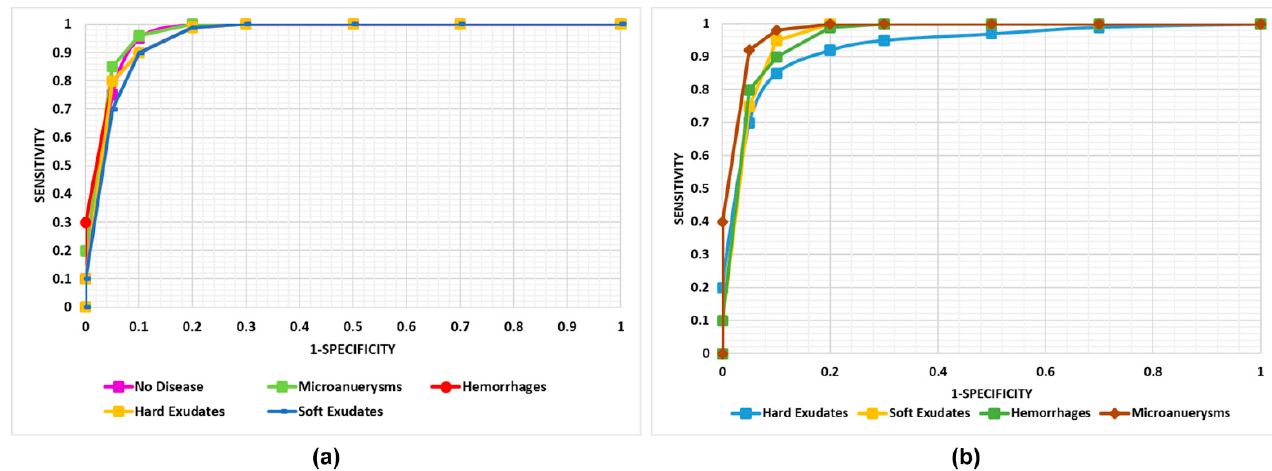
Figure 9. Cross dataset performance of our technique. ( a ) Test over the EYEPACS dataset. ( b ) Test over the Diaretdb1 dataset.